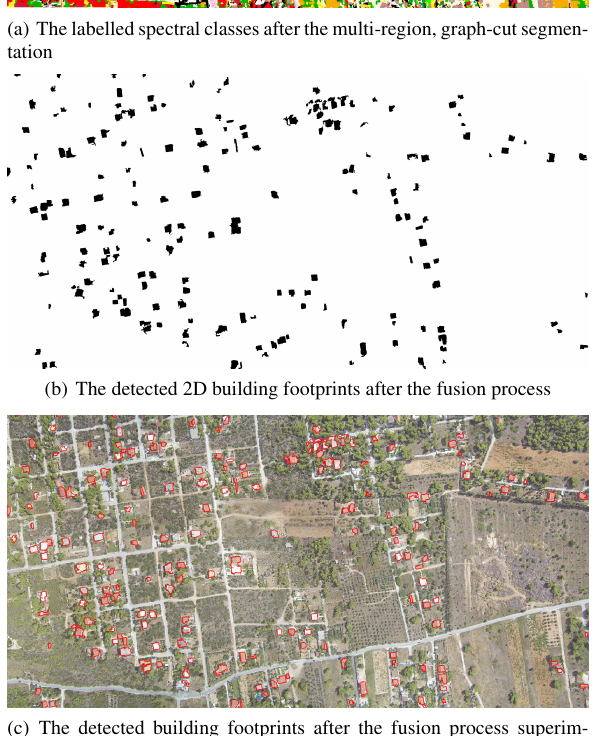
Figure 4: Based on an unsupervised segmentation, rule-based classification and data fusion process the developed algorithm managed to extract building footprints. A model-based approach further recovers their correct 2D and 3D